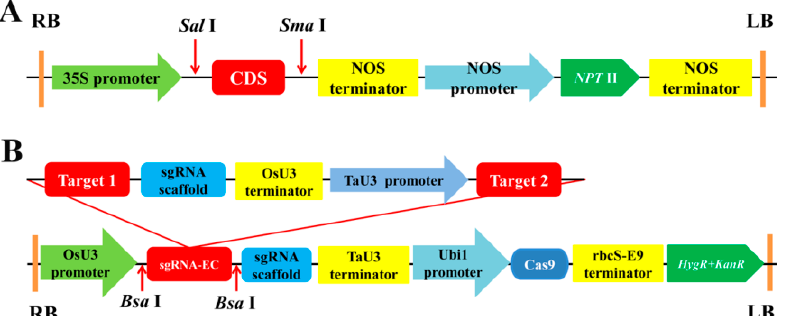
Figure 1. Schematic diagram of the recombinant vector. ( A ) schematic diagram of recombinant vectors OE- LpABCB21 and OE- LpPILS7 . ( B ) schematic diagram of recombinant vectors KO- LpABCB21 and KO- LpPILS7 . RB and LB are the right and left borders of the recombinant vector, respectively; NPT II is a selection marker gene for overexpression lines. HygR and KanR are selection marker genes for mutant lines. sgRNA-EC is a dual sgRNA expression cassette.